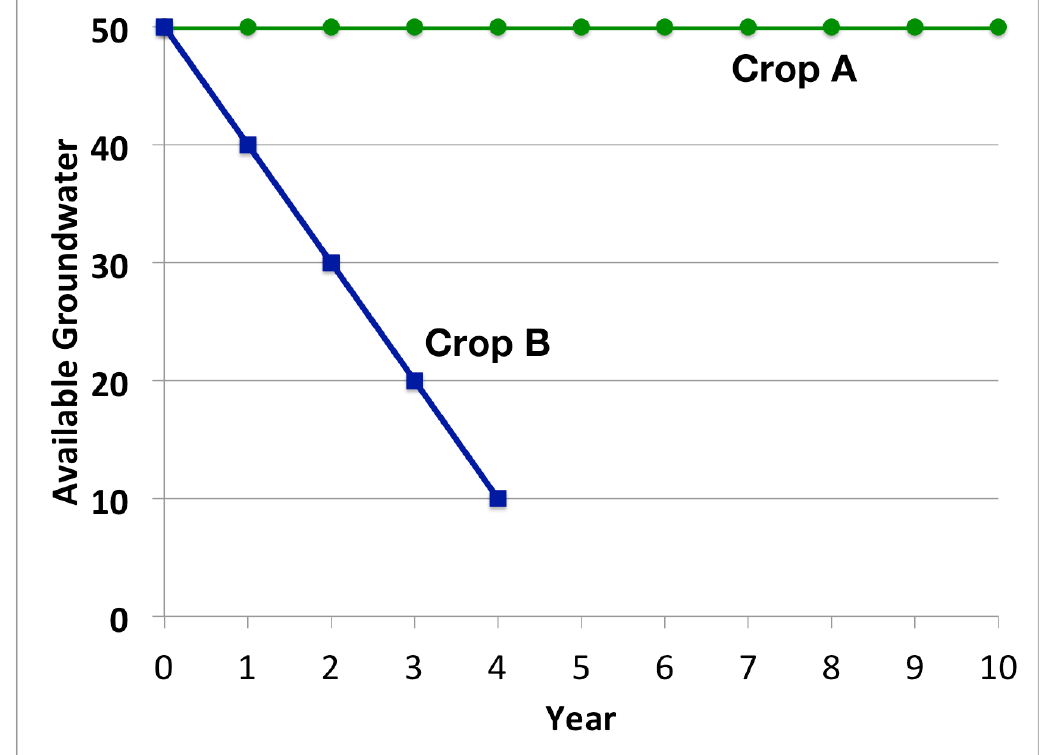
Figure 4. Comparison of Everyone Playing A vs Everyone Playing B (AAAAA vs BBBBB) If everyone plants Crop B every round, the groundwater supply would last for 5 rounds. Each participant would earn 25 units of income from their